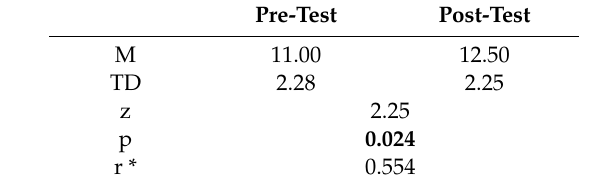
Table 9. Average (A), typical deviations (TD), Wilcoxon test results (Z), significance ( p ), and dMR value (r) of the total number of students in the pre-test and post-test in the self-motivation test. Pre-Test Post-Test